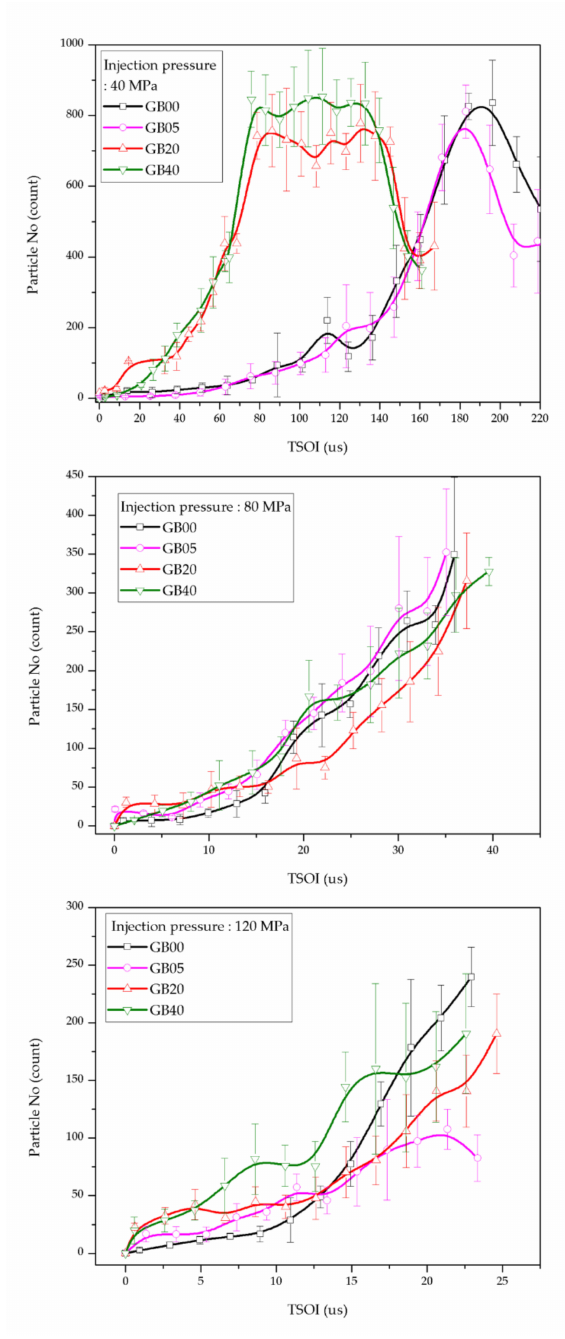
Figure 9. Particle numbers observed in the spray development of GB fuels according to the injection pressure. Top row: 40MPa, Middle row: 80 MPa, Bottom row: 120 MPa(GB00: gasoline 100% and biodiesel 0%, GB05: gasoline 95% and biodiesel 5%, GB20: gasoline 80% and biodiesel 20%, GB40: gasoline 60% and biodiesel